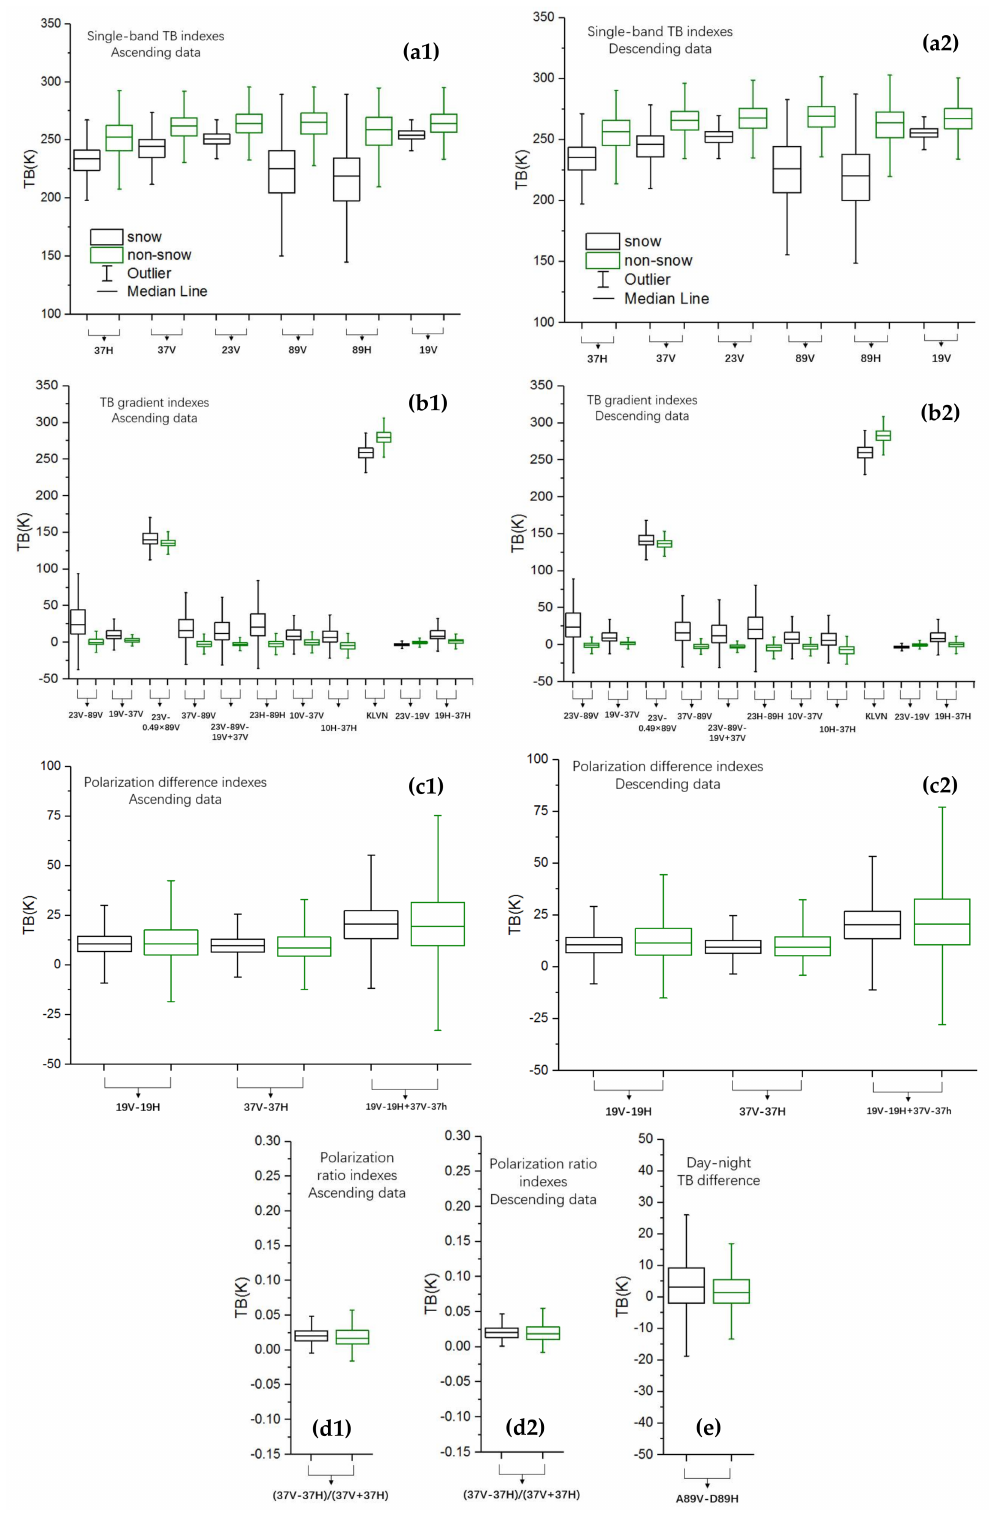
Figure 10. Box plots of the single-band indexes ( a1 , a2 ), the Tb gradient indexes ( b1 , b2 ), the polarization difference indexes ( c1 , c2 ), the polarization ratio indexes( d1 , d2 ) and the day–night Tb difference indexes ( e